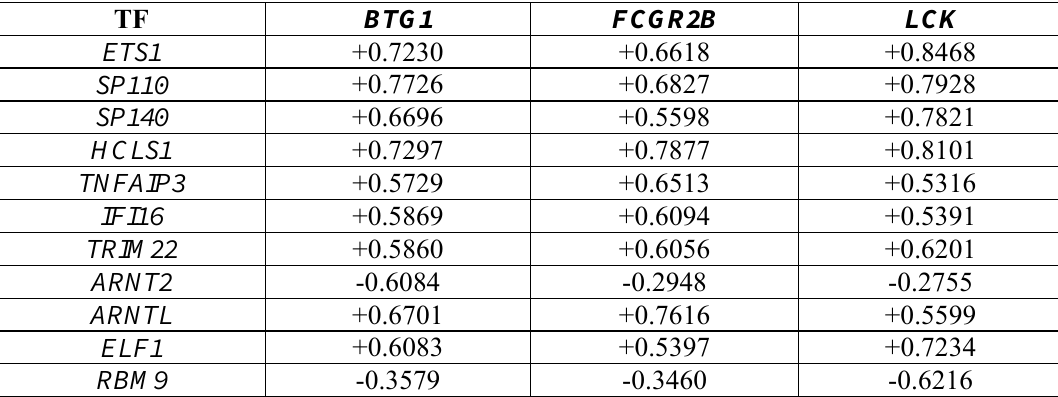
Table 7: Association analysis of BTG1, FCGR2B and LCK with transcription factors in terms of regulation pattern. TF BTG1 FCGR2B LCK ETS1 +0.7230 +0.6618 +0.8468 SP110 +0.7726 +0.6827